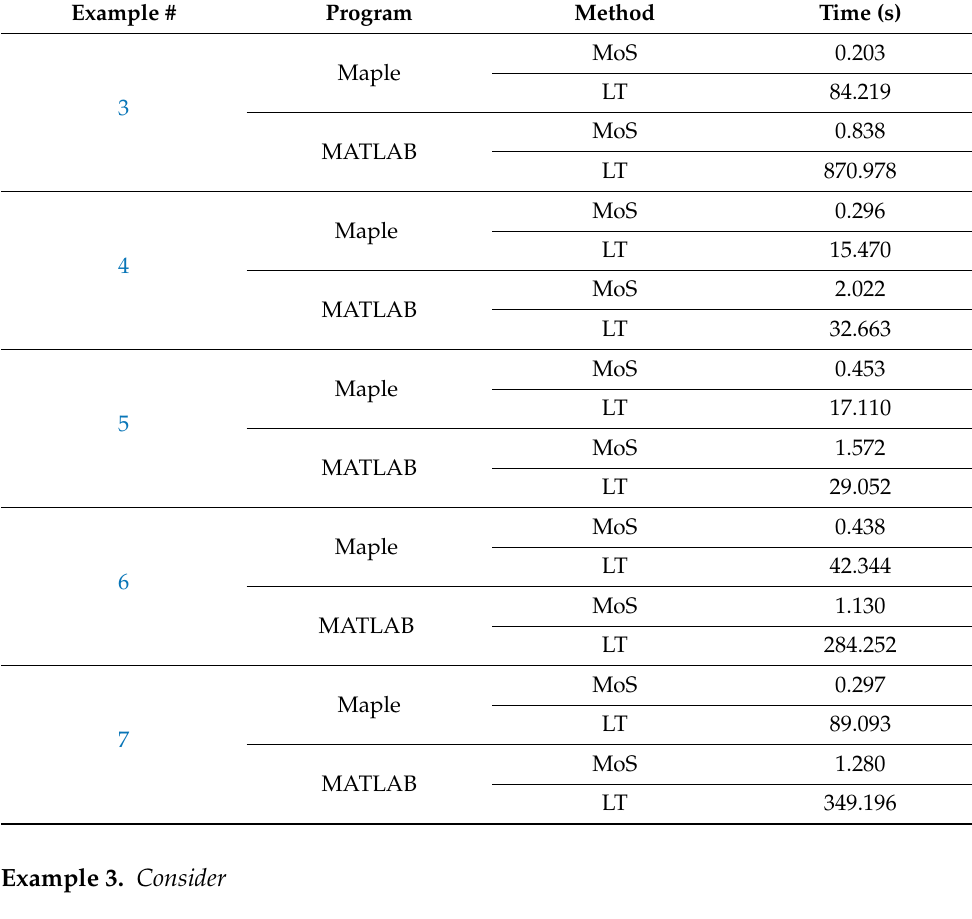
Table 2. Computation time comparison for the NDDE systems in Equations